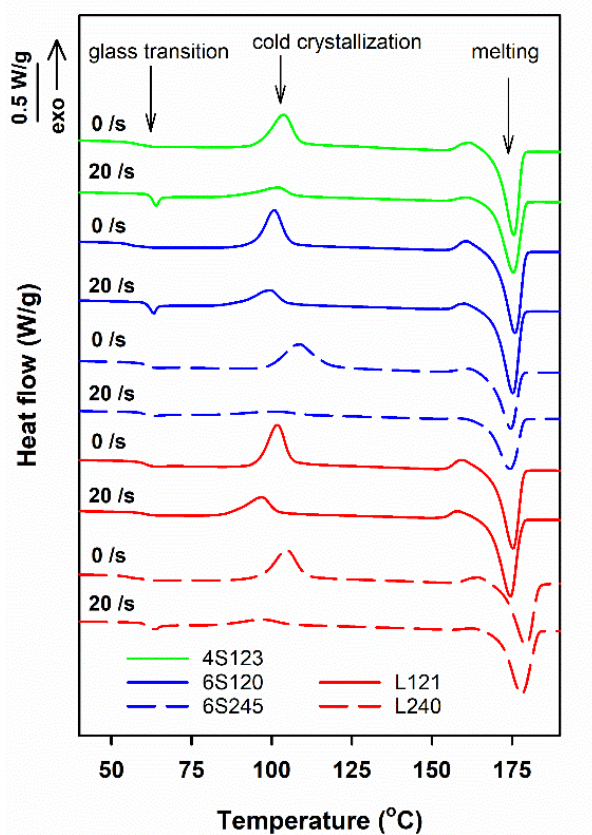
Figure 1. DSC heating thermograms of PLLAs sheared at 20 /s for 5 s at 150 °C and next cooled at 30 °C/min, and thermograms of control specimens cooled at 30 °C/min. The curves shifted vertically for clarity.